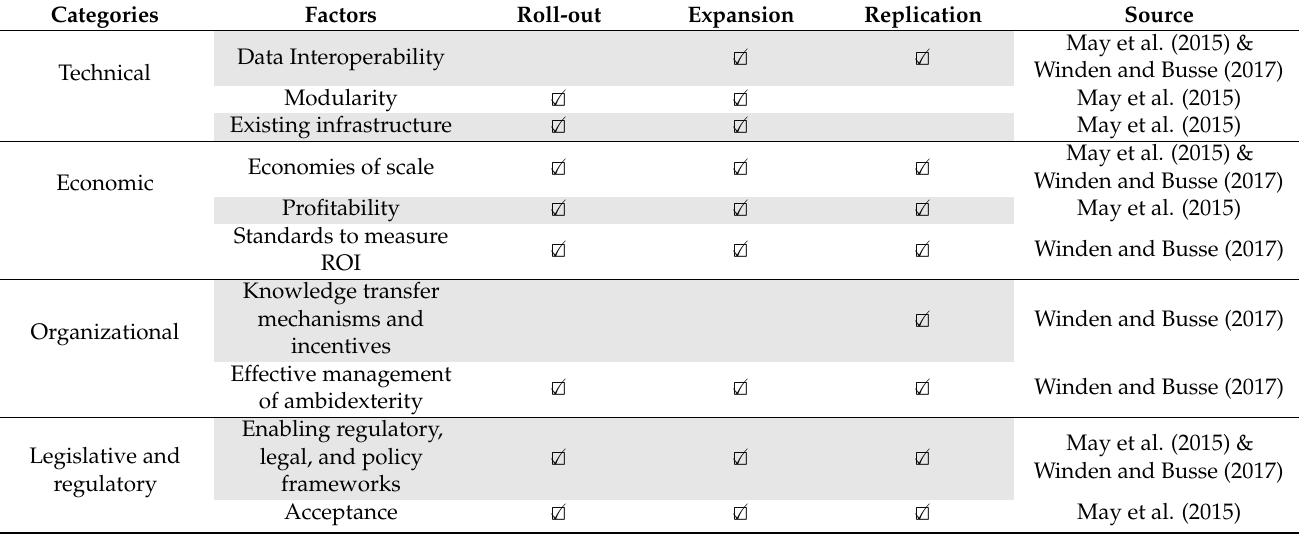
Table 2. Factors influencing projects scale